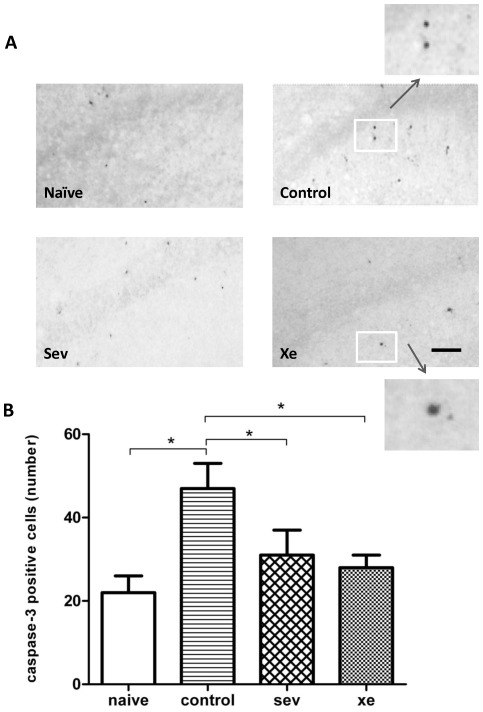
Caspase 3 expression in the hippocampus.Pups from control, sevoflurane or xenon groups experienced intrauterine hypoxia, when the dams were exposed in different gases during labor. Pups from naïve group were from vaginal delivery from surrogate mother. Photomicrographs show caspase 3 expression in the hippocampus on PND3, CA1, (A, 20×). B shows the quantification of caspase 3 positive cells. Results are expressed as mean ± SEM (n = 5). *p<0.05. Bar = 100 µm. The inserted box indicates the area being subjected to high magnification image.